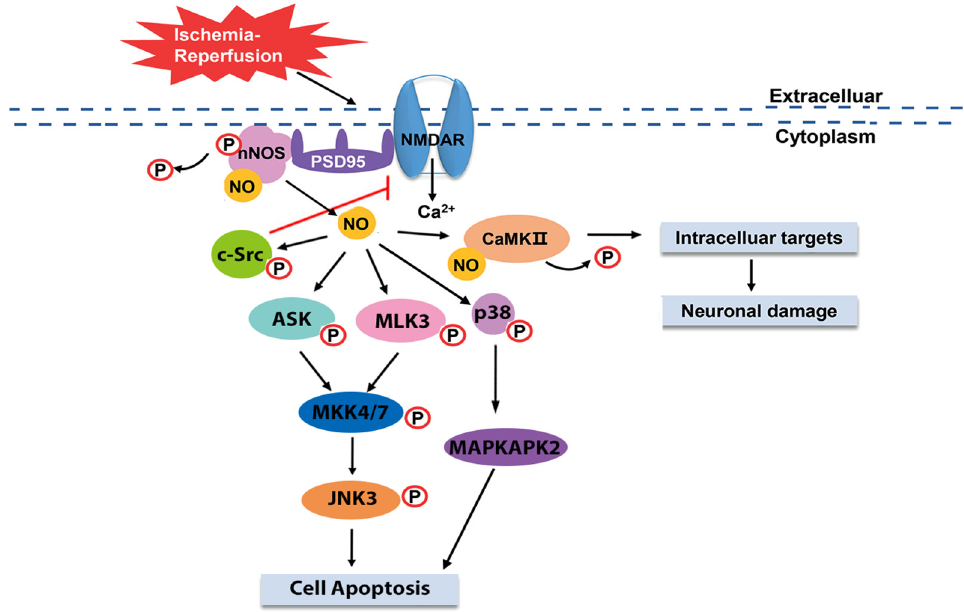
Figure 2. The NO signaling pathway, resulting in neuronal cell death during brain ischemia and reperfusion. During brain I/R, NMDAR forms a complex with nNOS through PSD95, resulting in nNOS activation and NO synthesis [20–23]. NO produced by nNOS activates c-Src through phosphorylation to inhibit the activity of NMDAR [32]. NO also phosphorylates downstream signaling molecules, including ASK, MLK3, and p38, which subsequently activates their downstream signaling proteins and finally stimulates the cell apoptosis pathway, resulting in cell death [24–28]. NO activates CaMKII through S-nitrosylation, resulting in neuronal damage [16]. NMDAR, N-methyl- D-aspartate receptor; nNOS, neuronal NOS; PSD95, postsynaptic density protein 95; ASK, apoptosis signal-regulating kinase; MLK3, mixed linage kinase 3; CaMKII, Ca2+/calmodulin-dependent protein kinase II; MKK4/7, mitogen-activated protein kinase kinase 4/7; JNK3, c-jun N-terminal kinase 3. Reproduced with permission from the European Review for Medical and Pharmacological Sciences , 2019